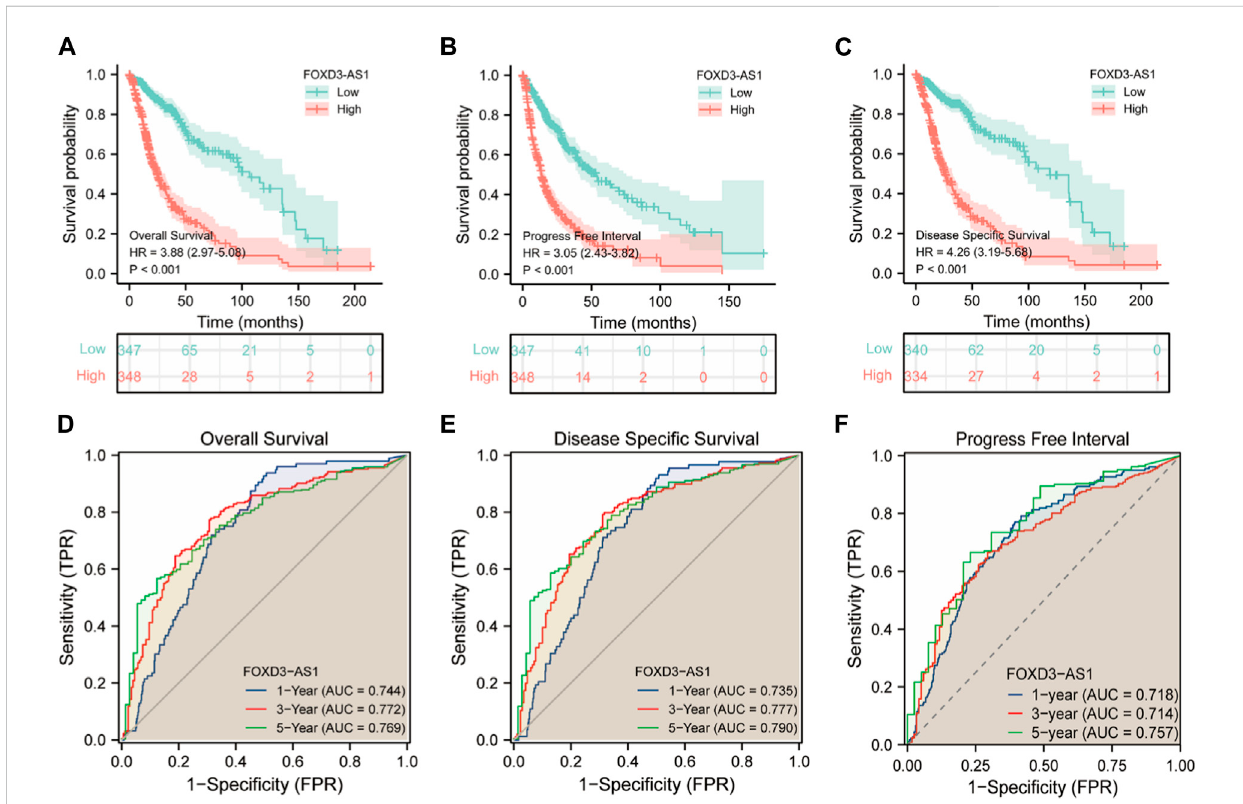
FIGURE 7 Correlation analysis of prognosis and survival of FOXD3-AS1. (A – C) were OS, DSS and PFI prognosis K-M survival curves between FOXD3-AS1 high and low expression groups; (D – F) FOXD3-AS1 is based on the ROC curve of OS, DSS and PFI 1 -, 3 -, 5-year survival